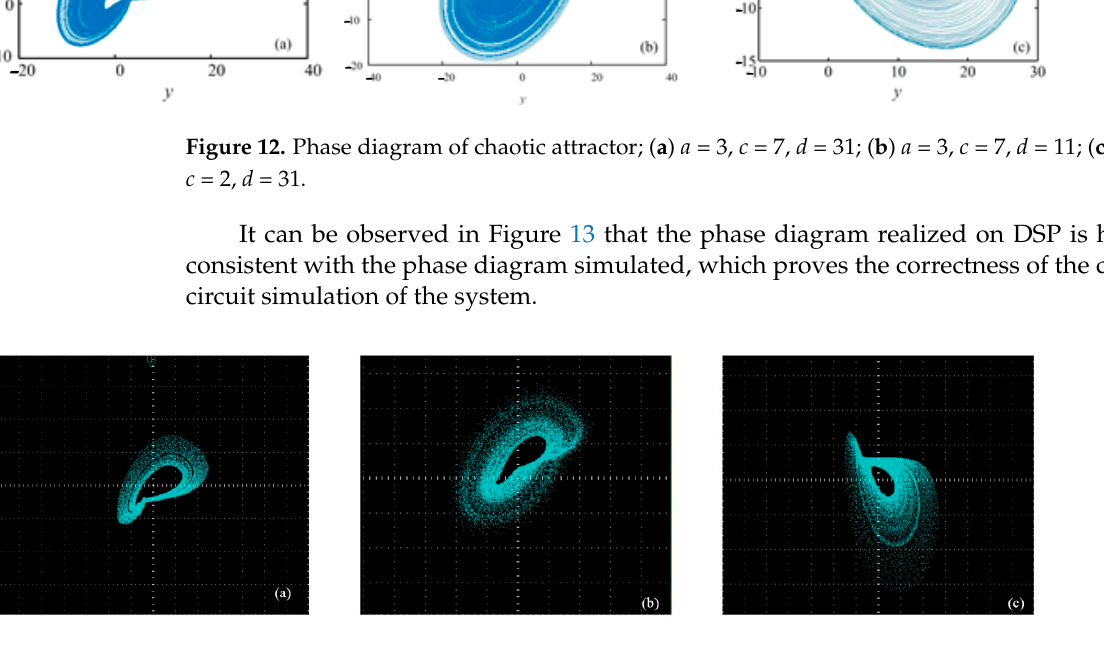
Figure 13. Chaotic attractor implemented on DSP platform; ( a ) a = 3, c = 7, d = 31; ( b ) a = 3, c = 7, d = 11; ( c ) a = 3, c = 2, d = 31.